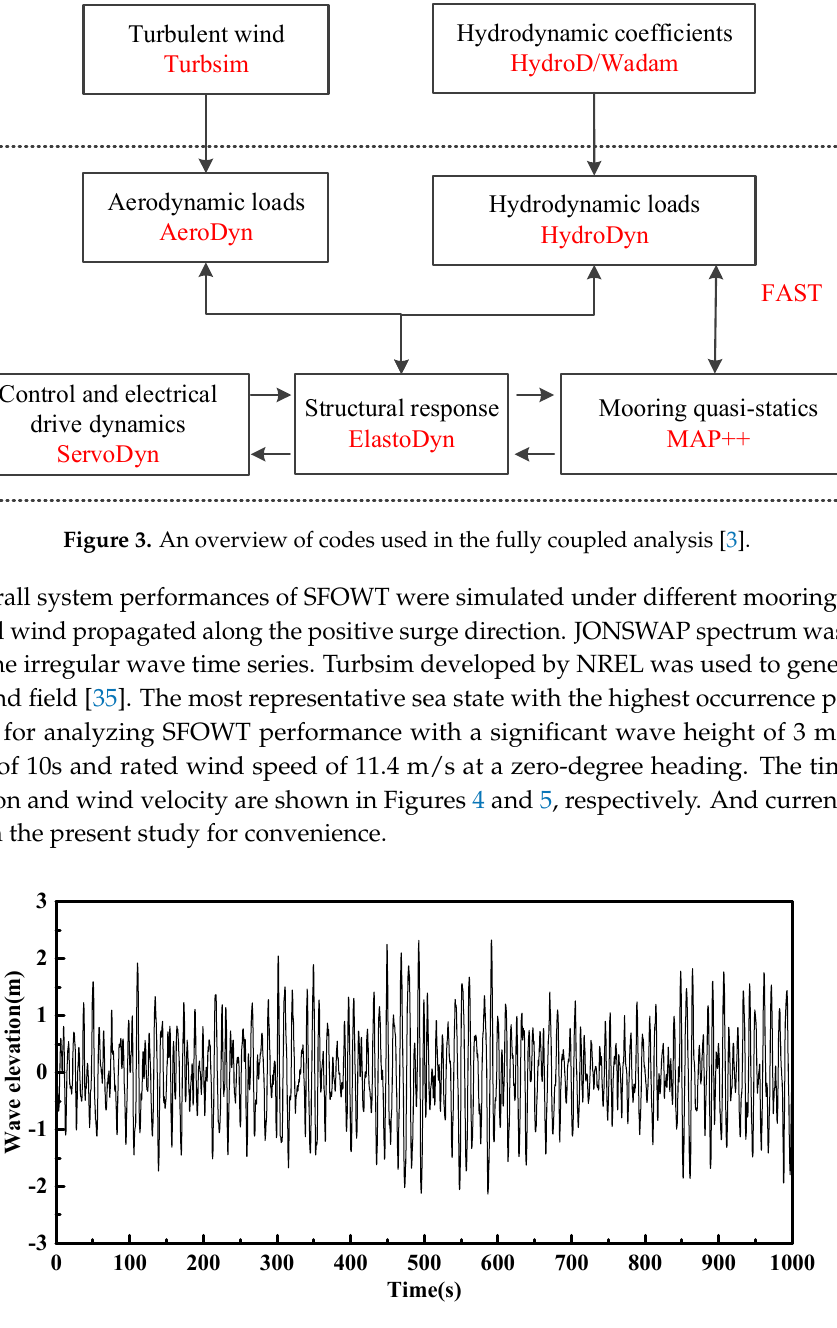
Figure 4. Time series of wave elevation.